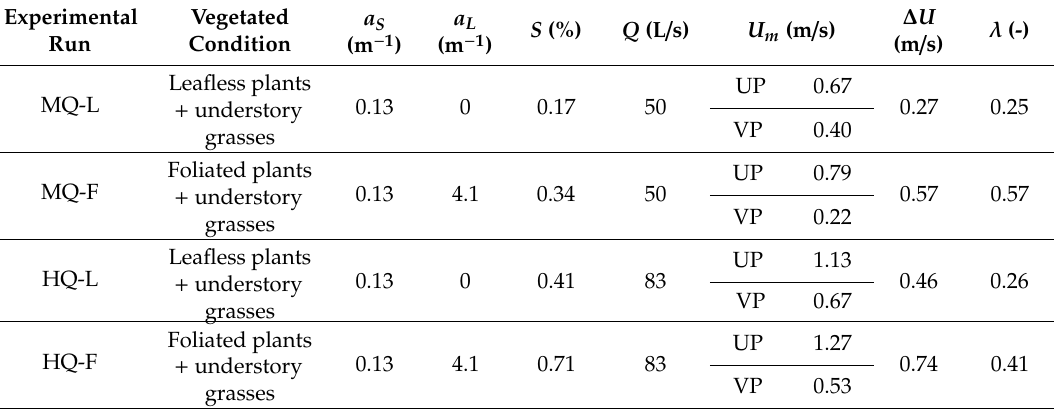
projected areas of the woody plant parts (stem) a s ; and volumetric one-sided leaf area a l , bed slope S